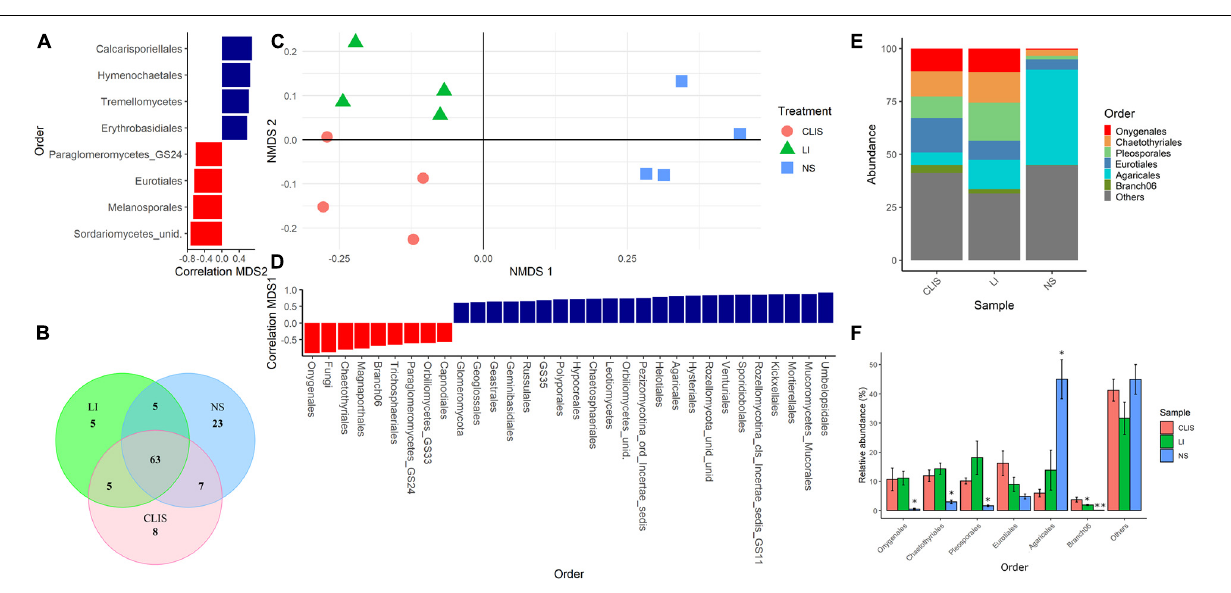
FIGURE 3 | Evaluation of the fungal community (Order) in the native savanna (NS), low-input recovering (LI), and crop-livestock integrated system (CLIS) areas obtained by sequencing of ITS rRNA genes. (A) Order with significant correlation with the second component of NMDS. (B) Venn diagram obtained from Order data. (C) Individual coordinates from NMDS results. (D) Order with significant correlation with the first component of NMDS. (E) Relative abundance of fungal orders in each area. (F) Percentage of relative abundance of fungal families in each area. Asterisks represent significance according to the Scott-Knott method p <